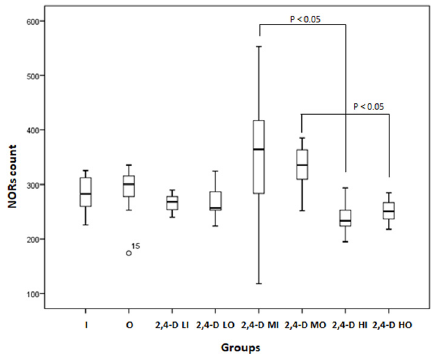
Figure 5. Number of nucleoli-organizing regions (NORs) in the esophageal epithelium in the experimental groups (n=79). Data are reported as median and interquartile ranges (Kruskal-Wallis test). Groups: I: Inhalation control group; O: Oral control group; 2,4-D LI: Group exposed to low concentration of 2,4-dichlorophenoxyacetic acid (2,4-D) by inhalation; 2,4-D LO: Group exposed to low concentration of 2,4-D orally; 2,4-D MI: Group exposed to moderate concentration of 2,4-D by inhalation; 2,4-D MO: Group exposed to moderate concentration of 2,4-D orally; 2,4-D HI: Group exposed to high concentration of 2,4-D by inhalation; 2,4-D HO: Group exposed to a high concentration of 2,4-D orally.